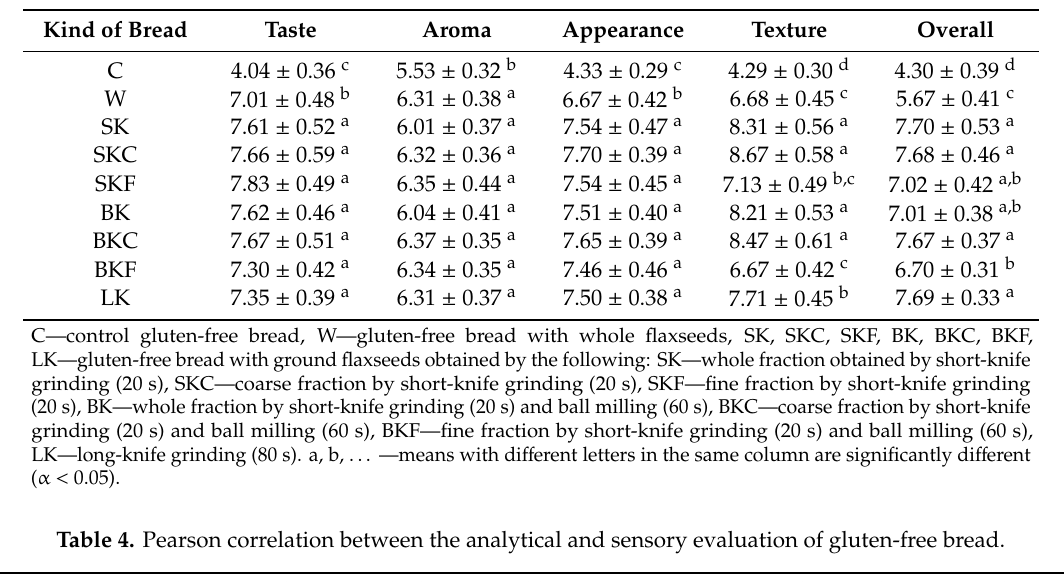
Table 4. Pearson correlation between the analytical and sensory evaluation of gluten-free bread. Color L* Color a* Color b* Crumbling Spec Volume Hardness Elasticity Cohesiv. Taste − 0.89 *